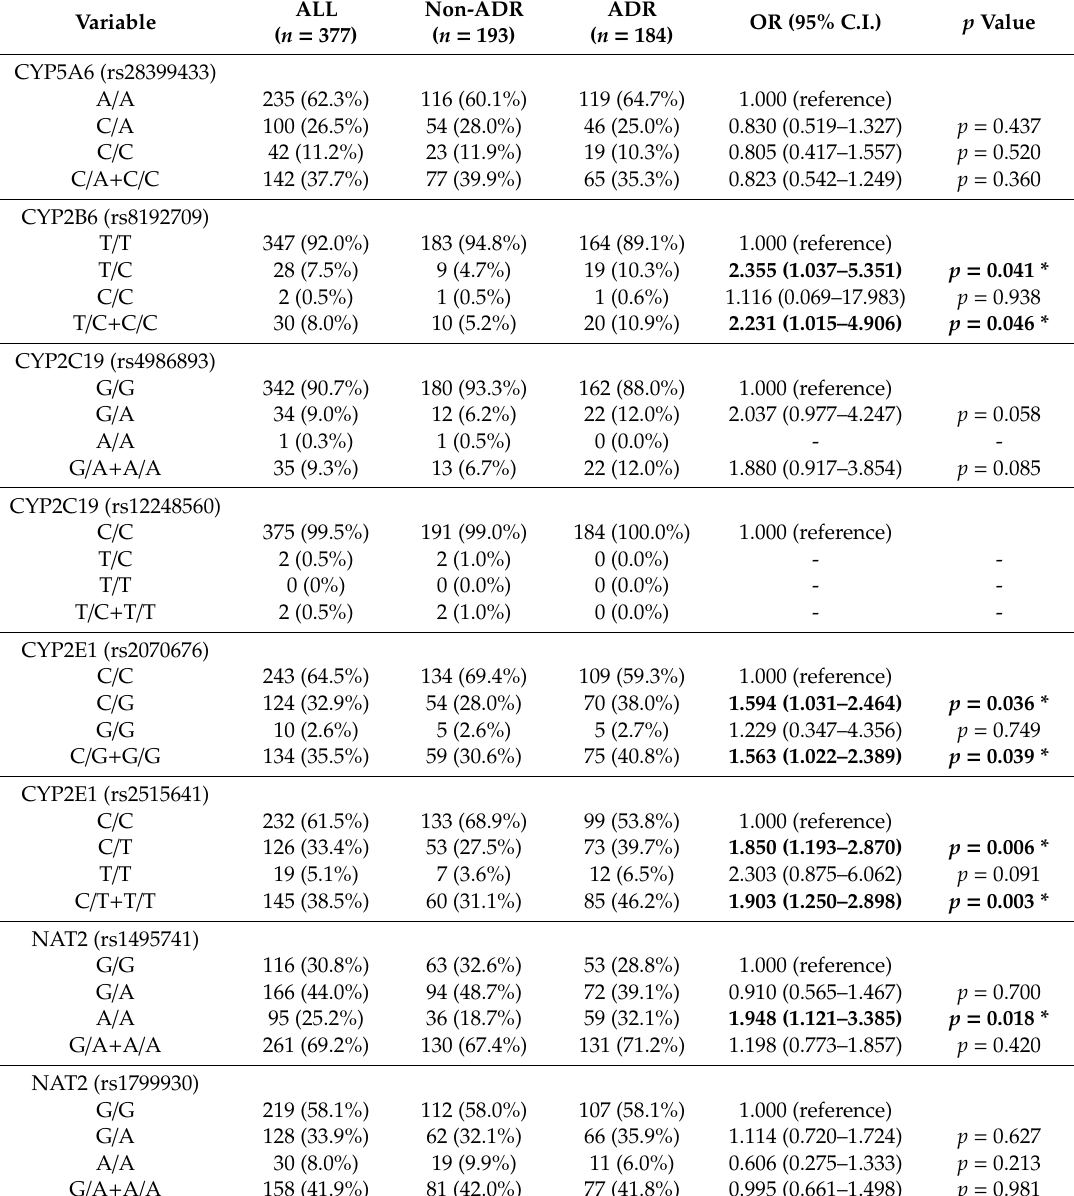
Table 3. Single nucleotide polymorphism frequencies of five drug-metabolic genes in 377